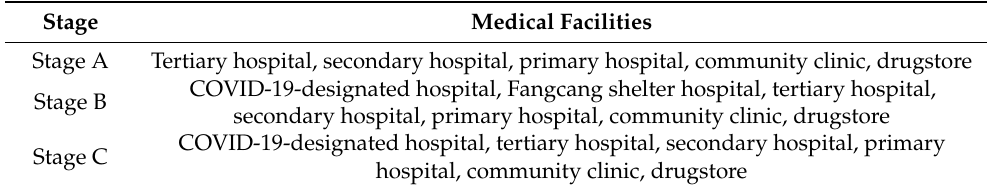
Table 6. Presence of medical facilities in the three